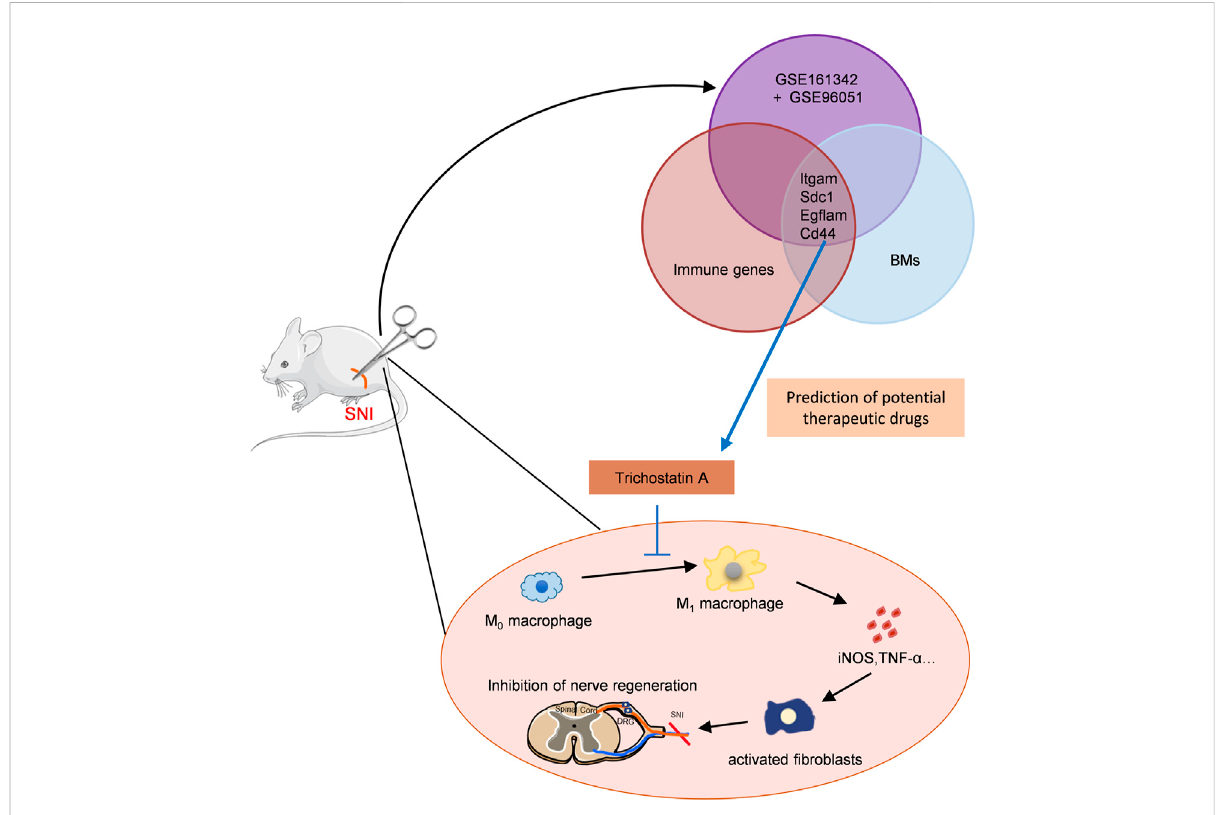
FIGURE 8 Schematic model showing discovery and validation of novel immunotherapeutic drug candidates for sciatic nerve injury (SNI). The key immune-relatedCGs wereidenti fi ed via PPI andimmunein fi ltration analyses.TSAwaspredictedas thetargeted drugsofthese genesbytheDSigDB database. TSA treatment promoted M2 macrophage polarization, and augmented IL-10 release while decreasing IL-1 β and TNF α levels, thus, enhancing axonal